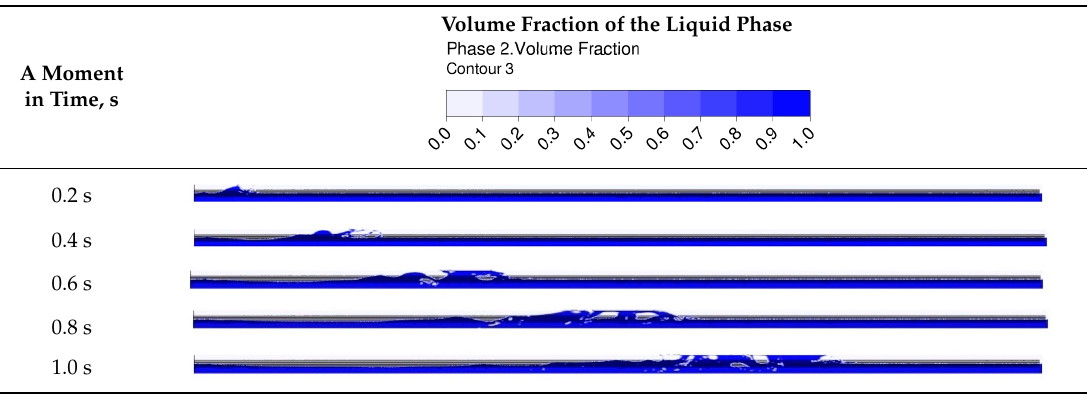
Table 5. Volume fraction of the liquid phase in time.